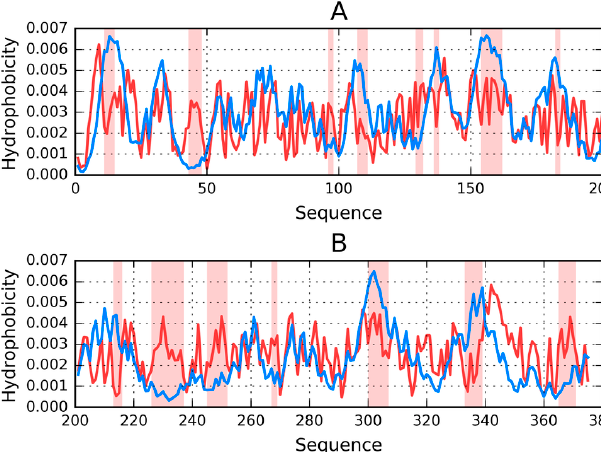
Figure 9. T (blue) and O (red) profiles for the F chain from F-actin (PDB ID 3J8I), divided into two parts for visibility: 1–200 ( A ) and 201–375 ( B ). Highlighted positions mark residues that cause discordance between those distributions (on the basis of visual inspection). The remainder of the chain is regarded as accordant with the theoretical distribution. It likely contributes to the protein’s structural stability—under the assumption that a well-ordered hydrophobic core and the presence of disulfide bonds both play a role in stabilizing tertiary conformations.